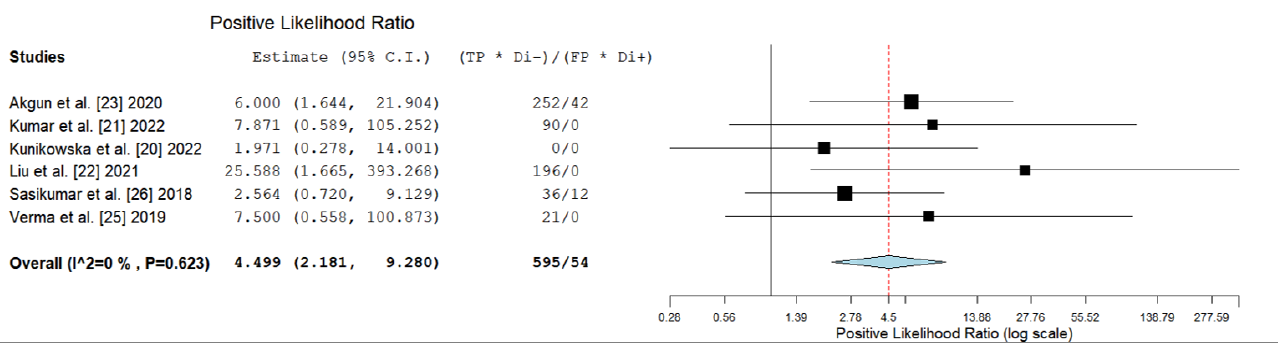
Figure 4. Positive likelihood ratio of the index test in high-grade glioma. Legend: 95% C.I. = 95% confidence interval; TP = true positive; TN = true negative; FP = false positive; FN = false negative.